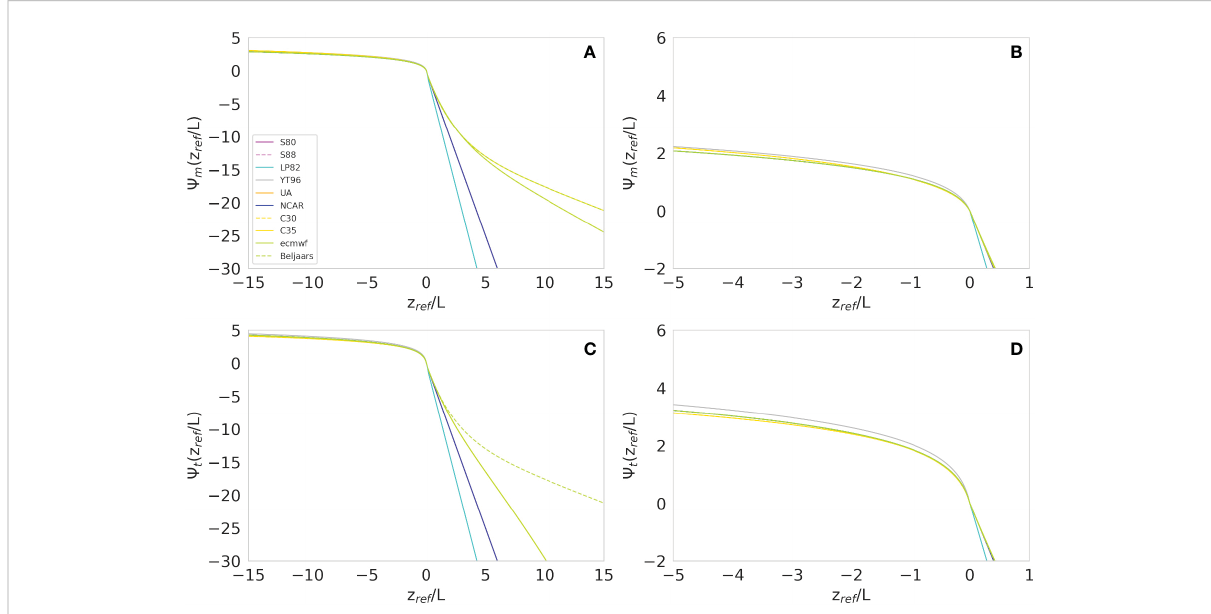
FIGURE 2 Stability functions versus z ref /L tsrv (A, B) for momentum, Y m , and (C, D) heat, Y t , for all bulk parameterizations provided in AirSeaFluxCode. Panels b and d are zoomed in to show the ranges of unstable conditions more clearly. Note that we have used z ref =10